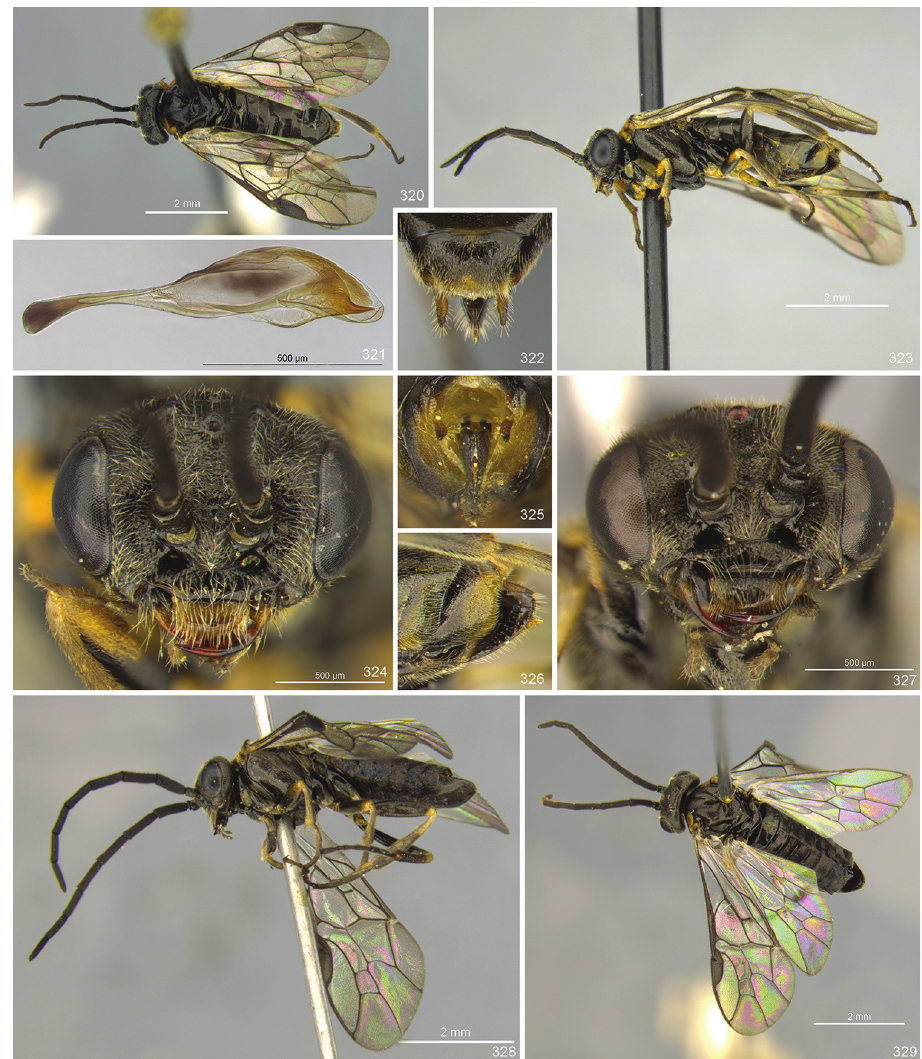
Figures 320–329. Pristiphora dedeara Liston & Prous, sp. n. 320, 322–326 female holotype